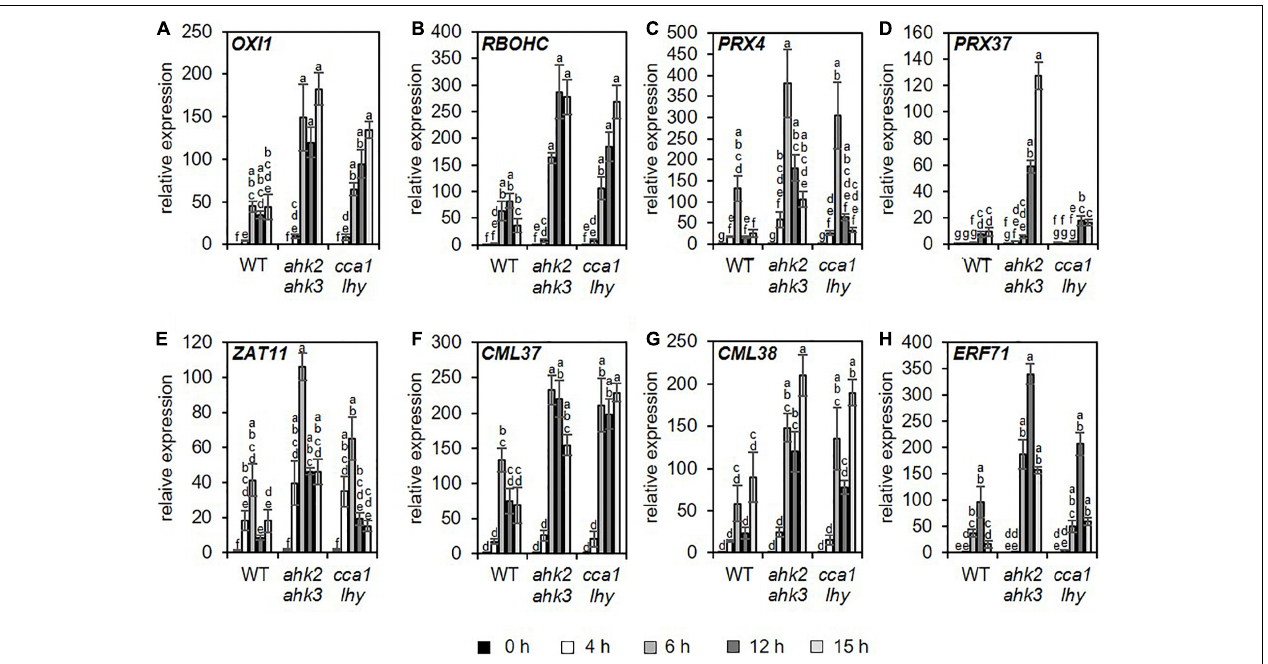
FIGURE 3 | Genes related to oxidative stress are upregulated in all genotypes in response to photoperiod stress. Plants were grown under short day conditions for 5 weeks before exposure to a 32 h prolonged light period (PLP) (see Figure 1A ). (A–H) Relative expression of OXI1 , RBOHC, PRX4, PRX37, ZAT11, CML37, CML28, and ERF71 in WT, ahk2 ahk3 and cca1 lhy plants at different time points during the night following PLP measured by qRT-PCR. Only results for the response to PLP-treatment are shown. An overview of all expression levels including control conditions is shown in Supplementary Table 12 . All values are expressed relative to WT control at 0 h, which was set to 1. Error bars represent SE ( n ≥ 3). Letters indicate different statistical groups ( p ≤ 0.05) as determined by ANOVA followed by Tukey’s post-hoc